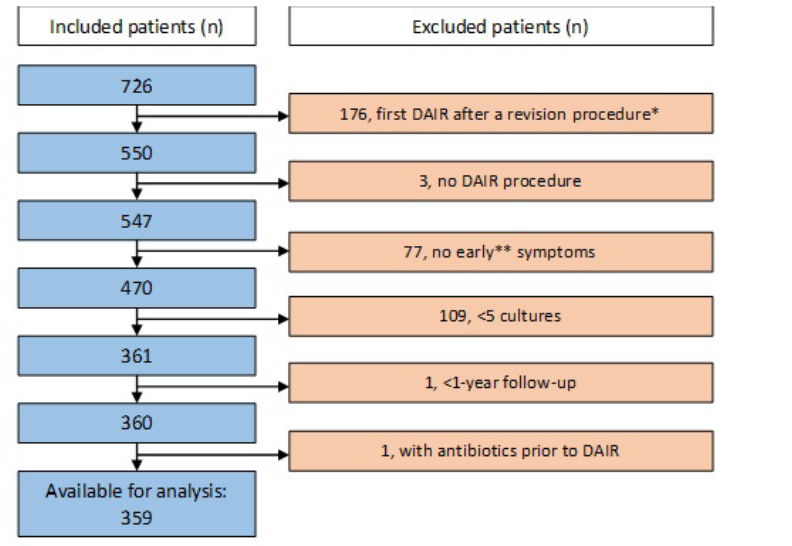
Figure 1. Flow diagram of the DAIR-treated patients included in the